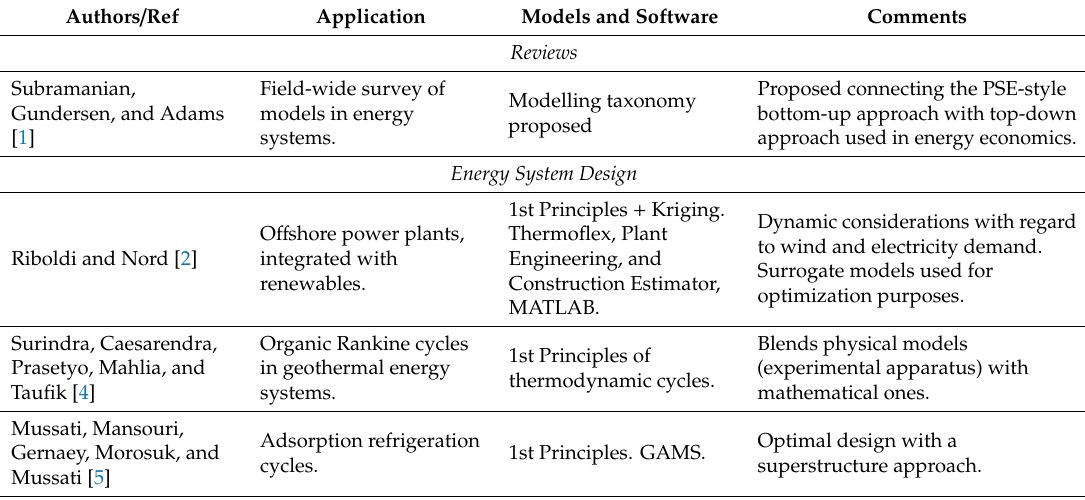
Table 1. Summary of articles in this Special Issue, categorized by problem